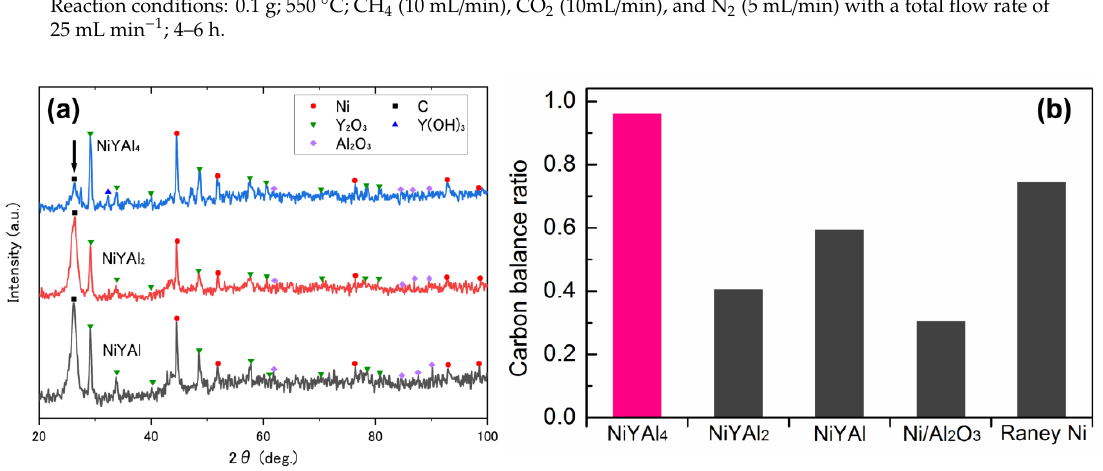
Figure S1: X-ray di ff ractograms of NiYAl4, NiYAl2, and NiYAl intermetallic precursors, Figure S2: X-ray di ff ractograms of the NiYAl4, NiYAl2, and NiYAl samples obtained after the preferential oxidation with CO + O2 gas mixture, Figure S3: (left) Photograph of the initial and spent NiYAl-derived catalyst. The degree of carbon coking was estimated from the increase in volume between the initial and spent samples. (right) Photograph of the spent NiYAl-, NiYAl2-, and NiYAl4-derived catalysts. The initial NiYAl2- and NiYAl4-derived samples were similar in appearance to the initial NiYAl-derived catalyst. Figure S4: TG analysis of the spent catalysts derived from NiYAl, NiYAl 2 , and NiYAl 4